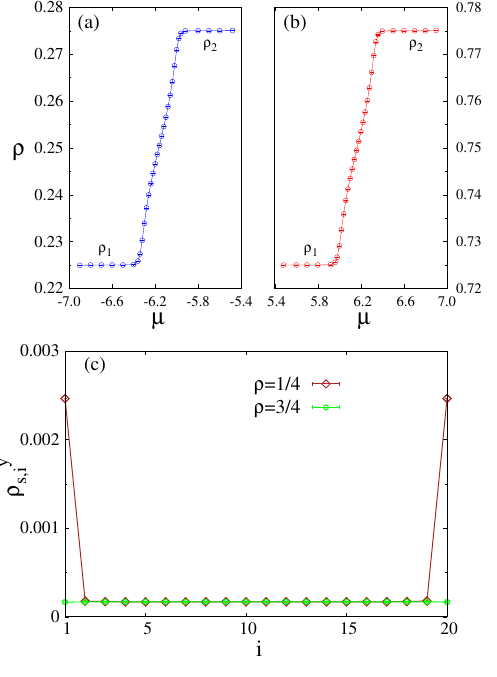
Figure 7: Splitting of the plateau at: (a), ρ = 1 / 4 with W = 6.0 ; and, (b), ρ = 3 / 4 0 = − 6.0, when open boundary conditions at W 0 are applied along the x -direction on a 20 × 20 honeycomb lattice. (c) The superfluid density ρ y for different stripes ( i ) of the same 20 × 20 s , i open lattice measured for µ = − 6.16 ( ρ = 1 / 4) = 6.0. Here and µ = 6.16 ( ρ = 3 / 4) with W 0 we take t = 1.0 and β = 120.